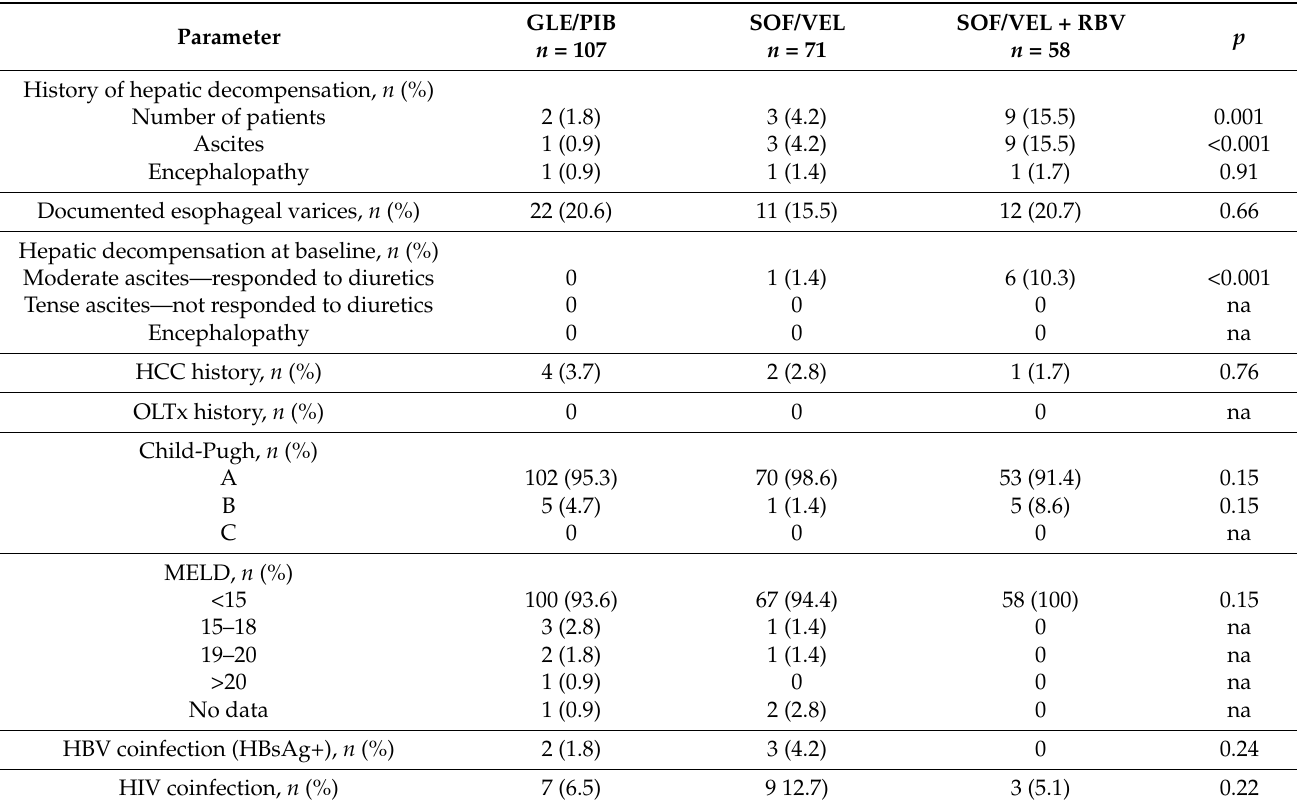
Table 2. Characteristics of the liver disease in GT3 HCV infected patients with liver cirrhosis treated with pangenotypic